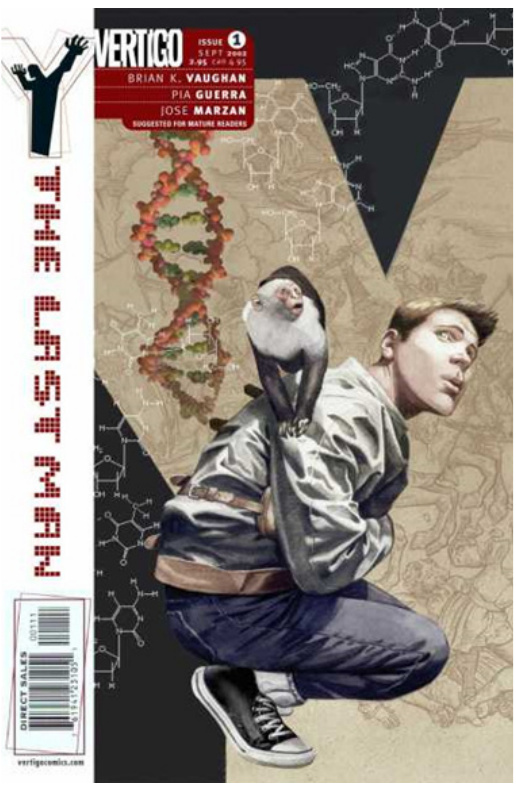
Figure 1. Y: The Last Man: Unmanned Vol. 1 (2002), cover by J. G.